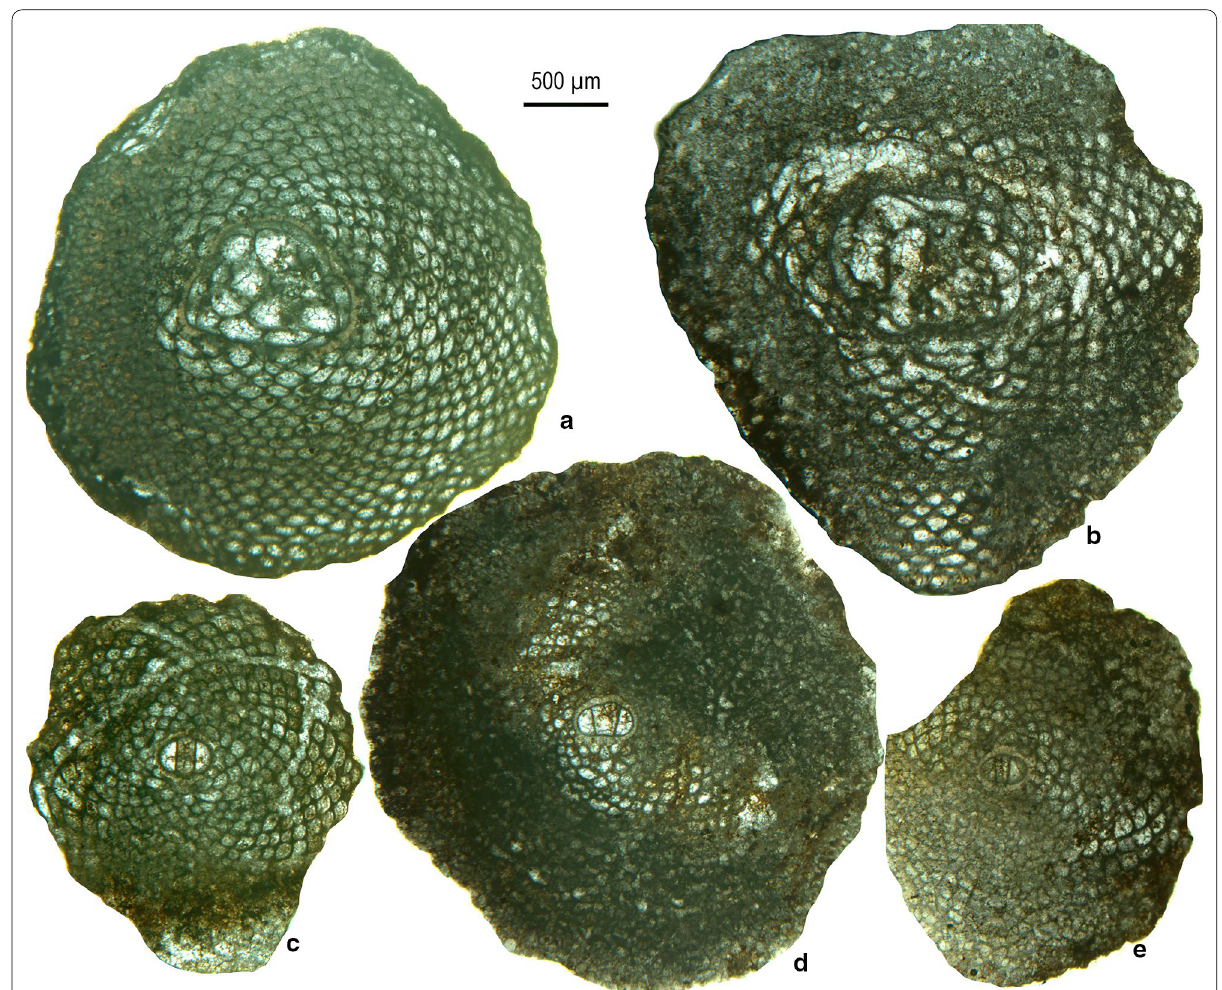
Fig. 22 Equatorial sections of O. gensacicus ( a–b ) and O. ‘medius’ ( c–e ) from the Simsima Formation in the Buraymi region, Oman. a B28-27. b B32-9. c B32-20. d B32-8. e